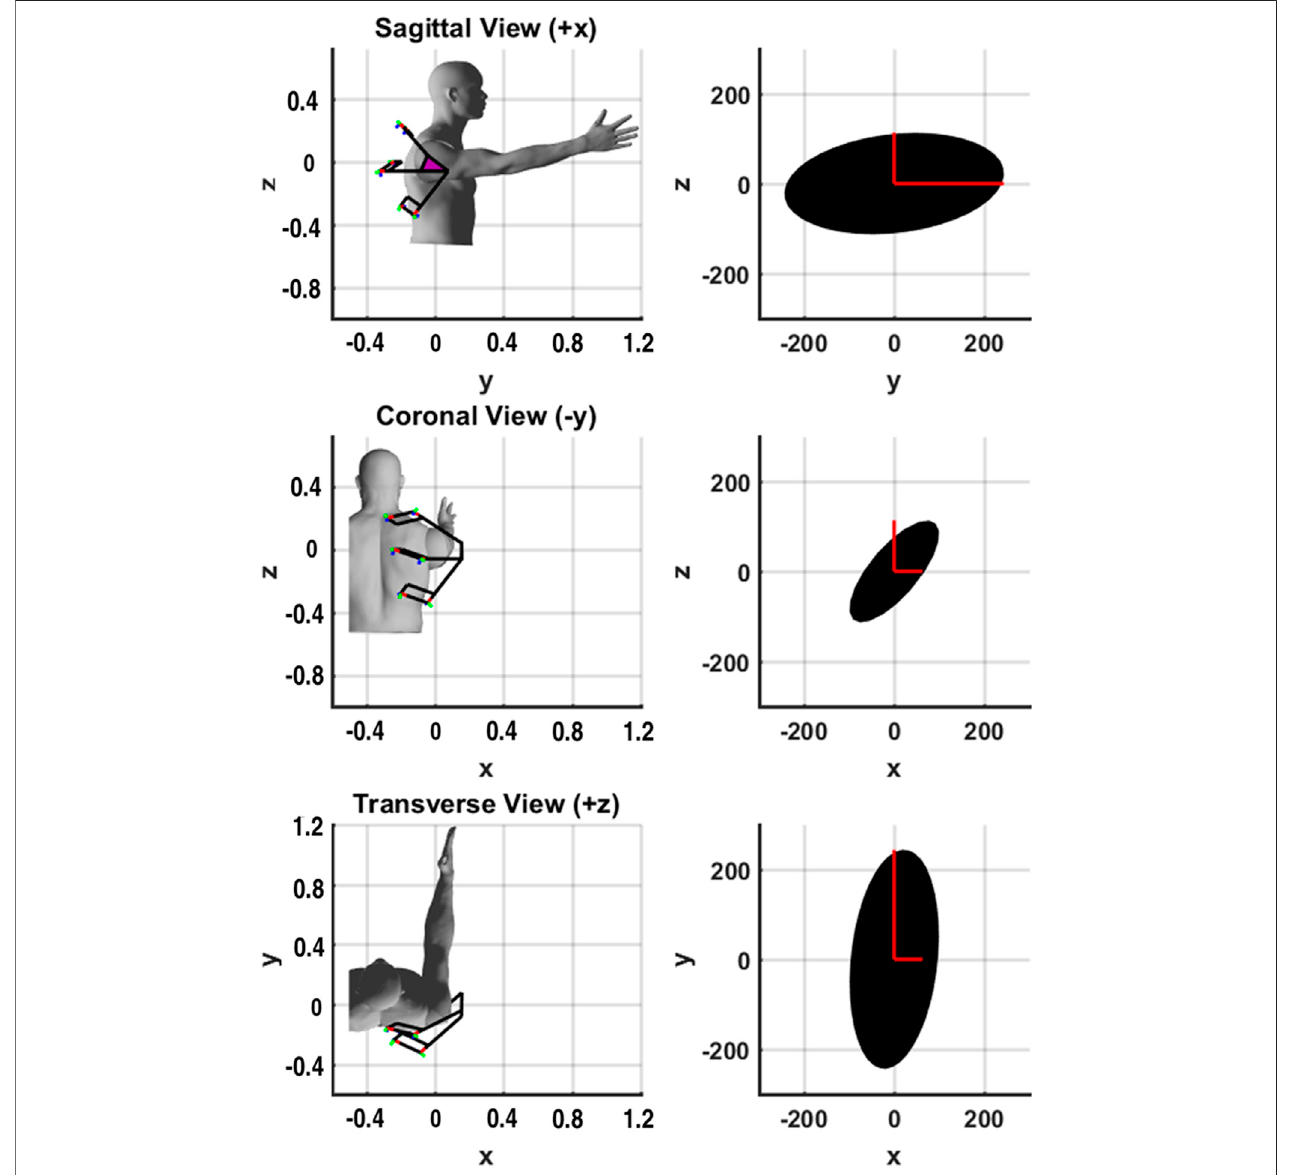
FIGURE 6 | Experimental setup for evaluating the 4B-SPM prototype stiffness oriented at 90 ° fl exion. (A) 4B-SPM Shoulder exoskeleton (B) 7-DoF robotic arm (LBR iiwa R820, KUKA, Germany) (C) 6-axis load cell (Delta IP65, ATI, NC). The shoulder exoskeleton was mechanically coupled to the load cell, which was in turn coupled to the 7-DoF robotic arm. The roll, pitch and yaw angles of the shoulder exoskeleton about its center-of-rotation O are represented ψ , θ and ϕ , respectively.